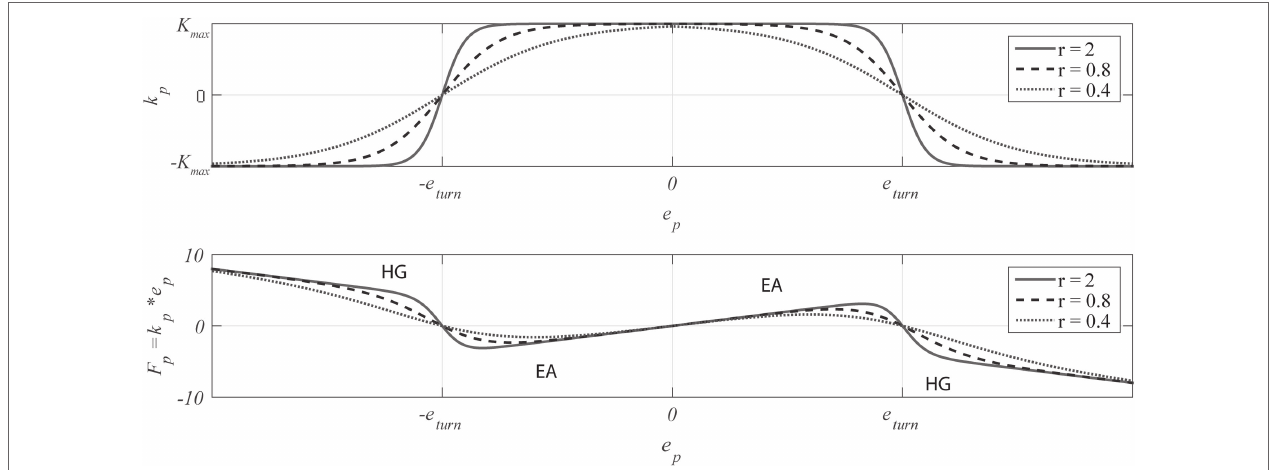
FIGURE 4 | Combined sigmoid function and its resulting perpendicular force . The proportional gain k p is function of the subject’s ongoing perpendicular error, limits dangerous and discouraging large errors (errors larger than e turn ) with haptic guidance (HG), while augmenting awareness of task relevant errors by means of error amplification